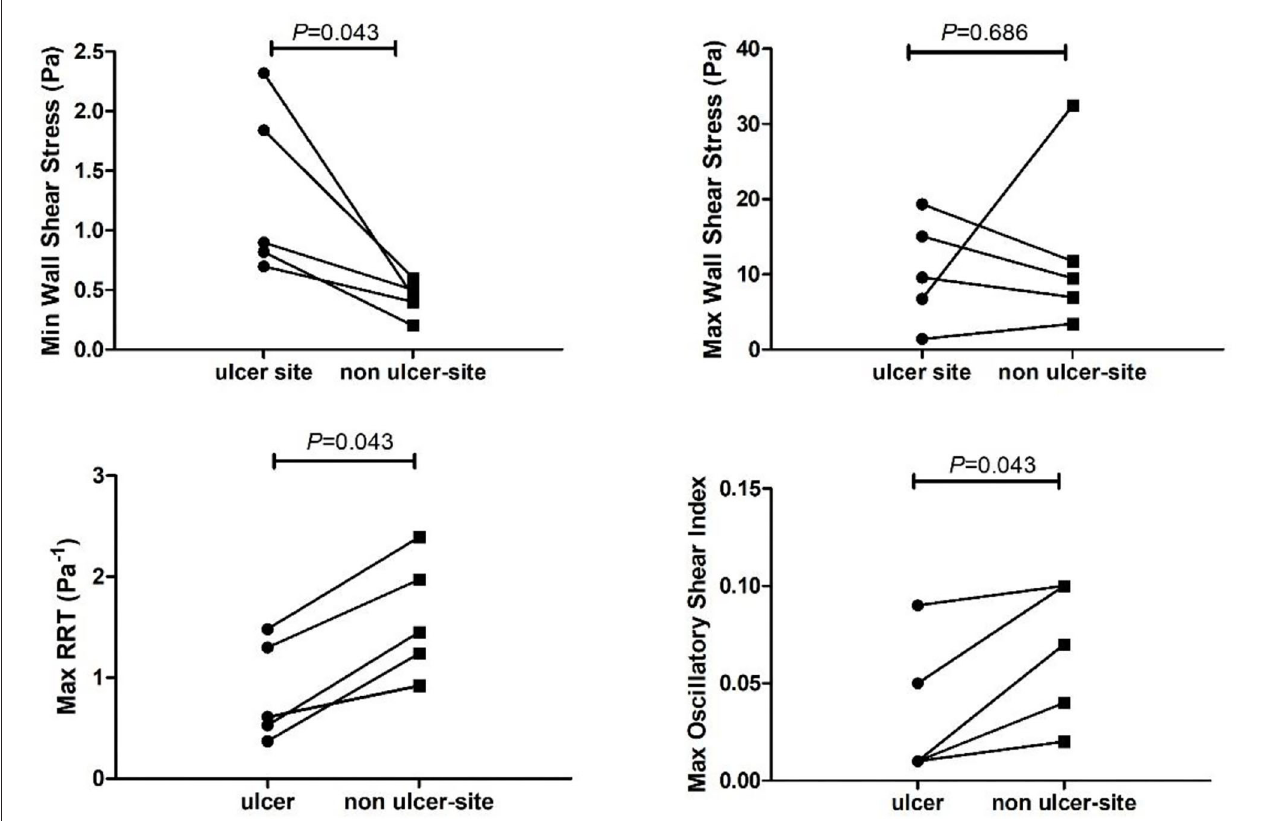
FIGURE 4 | Time varying wall shear stress at the ulcer-site (ulcer) vs. the non-ulcer site (remainder of the plaque) within a carotid artery. RRT, relative residence time.